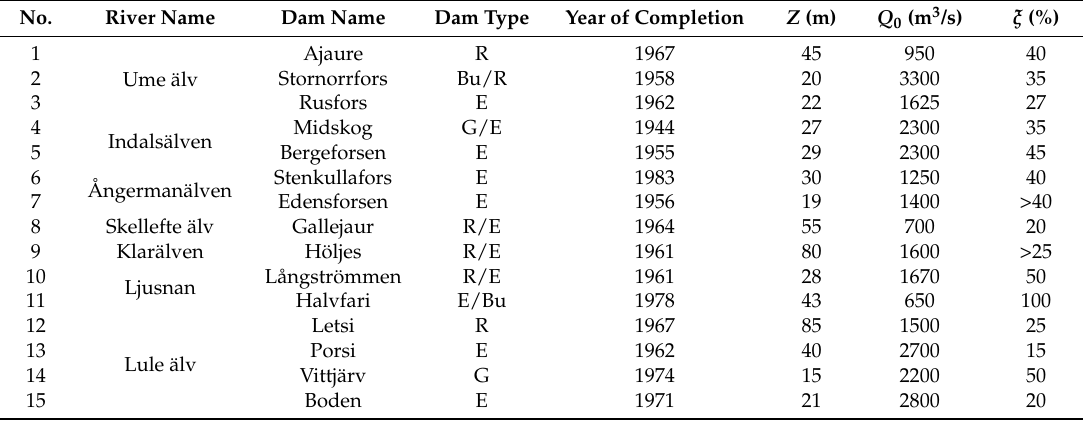
Table 1. Higher design floods as required by the updated flood criteria in